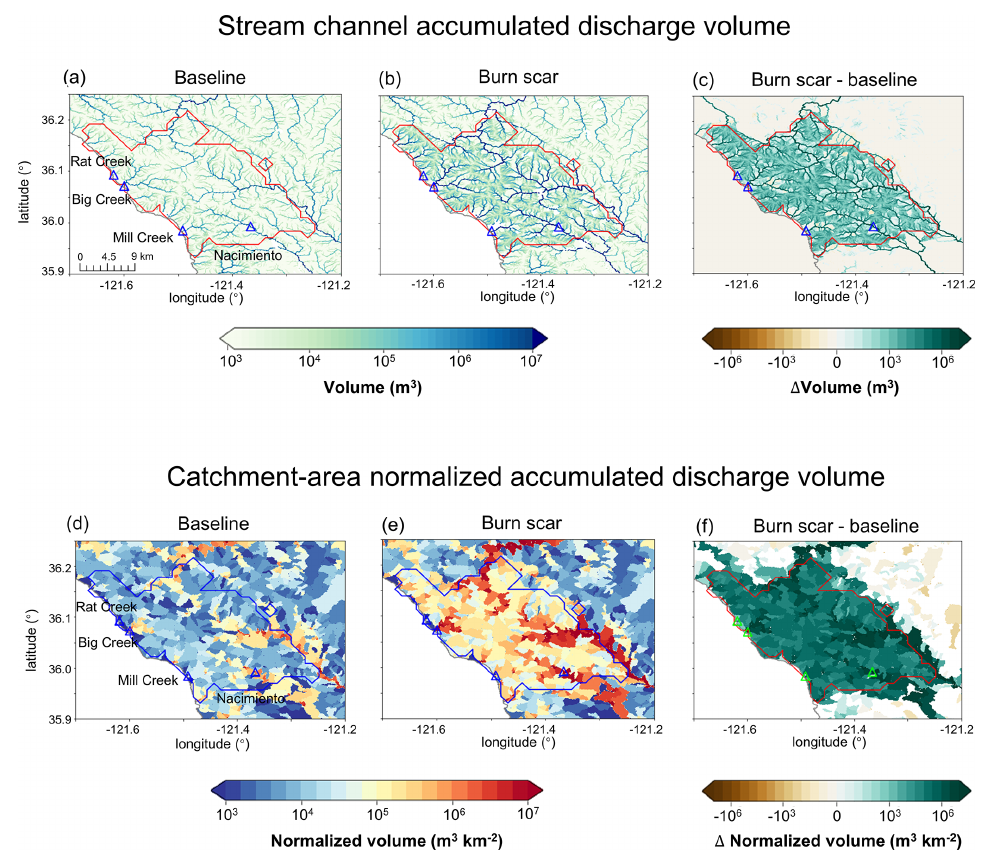
Figure B6. Accumulated discharge volume at individual stream level for the (a) baseline and (b) burn scar simulations and (c) the difference between burn scar and baseline simulations (m 3 ). Total discharge volume is accumulated from 27 January 00:00 to 28 January 12:00. (d– f) Normalized discharge volume by catchment area at catchment level (m 3 km − 2 ; shading; Santi and Morandi, 2013). For each catchment, the discharge volume is accumulated at the catchment outlet from 27 January 00:00 to 28 January 12:00 divided by catchment area. Triangles stand for debris flow deposition locations and are annotated in (a) and (d)